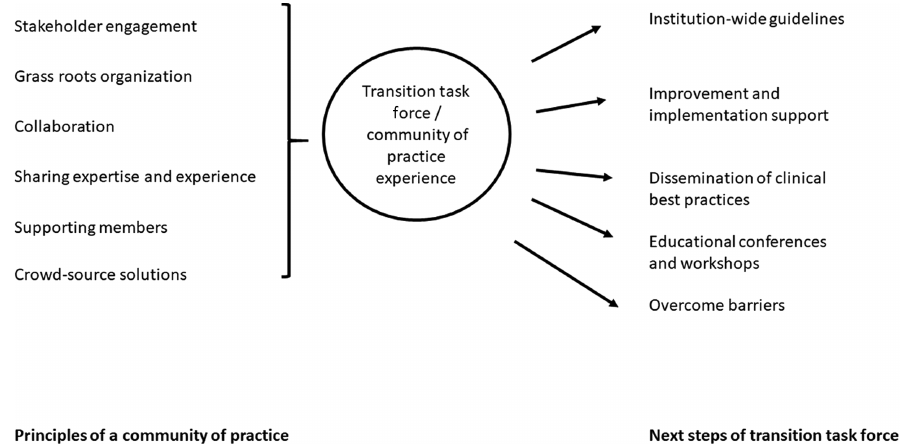
Figure 1: Overview of the principles and next steps of the Pediatric to Adult Transition Task